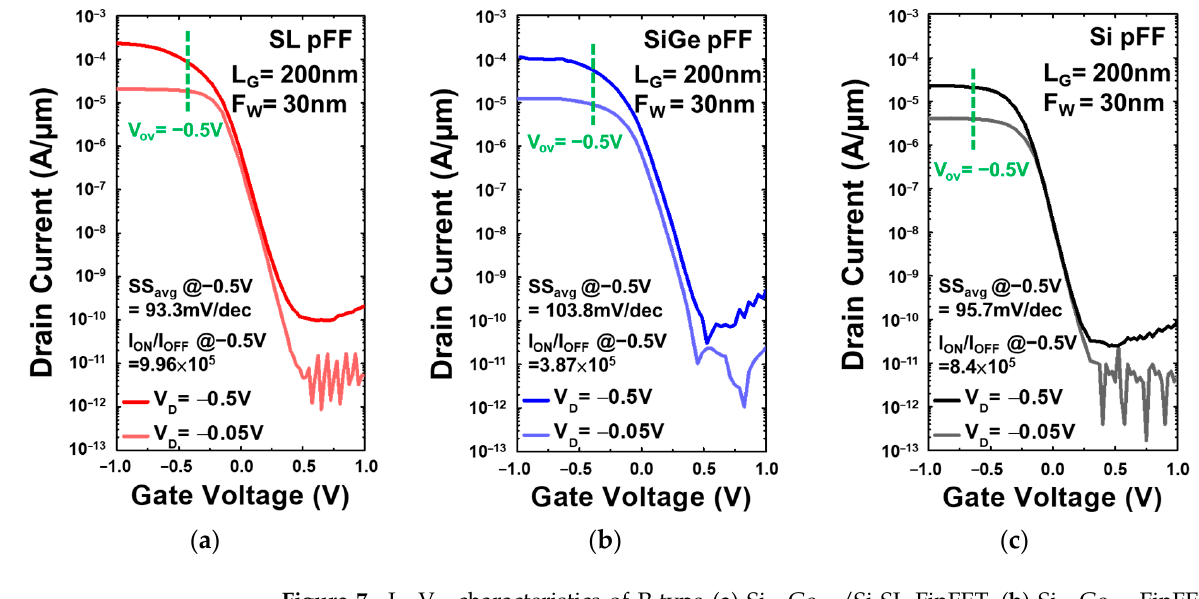
Figure 7. I D -V G characteristics of P-type ( a ) Si 0.8 Ge 0.2 /Si SL FinFET, ( b ) Si 0.8 Ge 0.2 FinFET, and ( c ) Si FinFET. The I D is normalized by the footprint width, and V TH is extracted at a constant I D of 10 − 7 A/µm. I ON is extracted at V OV = V D = − 0.5 V.